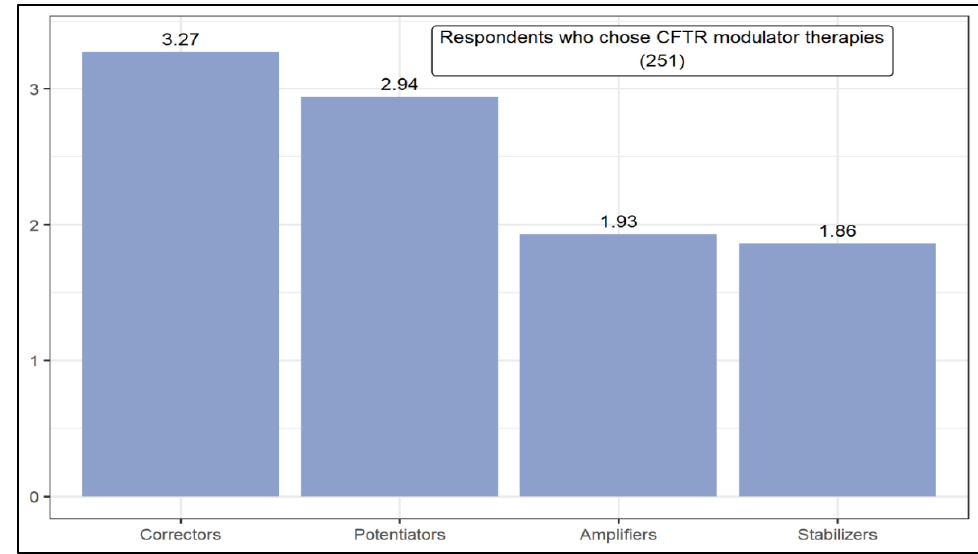
Figure 2. Ranking of cystic fibrosis transmembrane regulator (CFTR)modulator therapies.